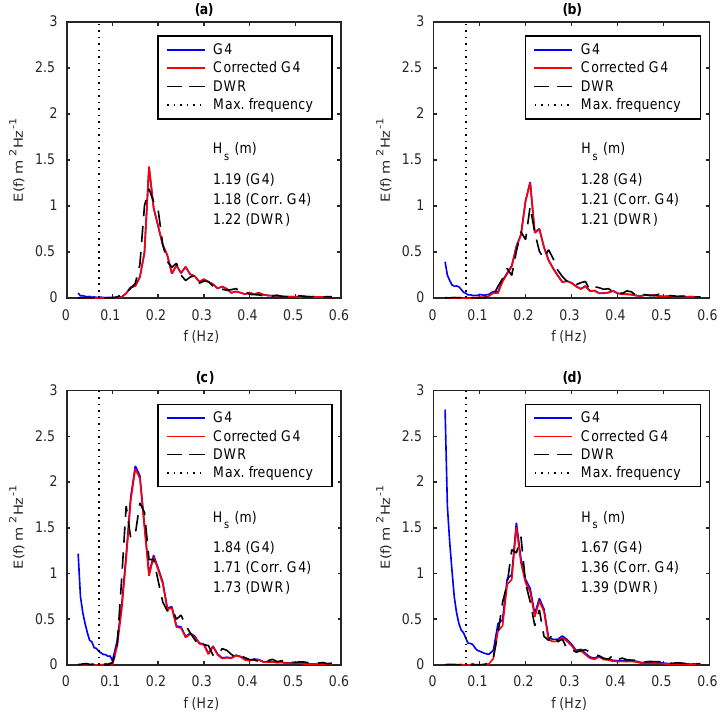
Figure 7. The power law method applied to four example wave spectra from May 2015 with different amount of erroneous trend present. The significant wave height H s is calculated for the original G4 data, the corrected G4 data and the DWR